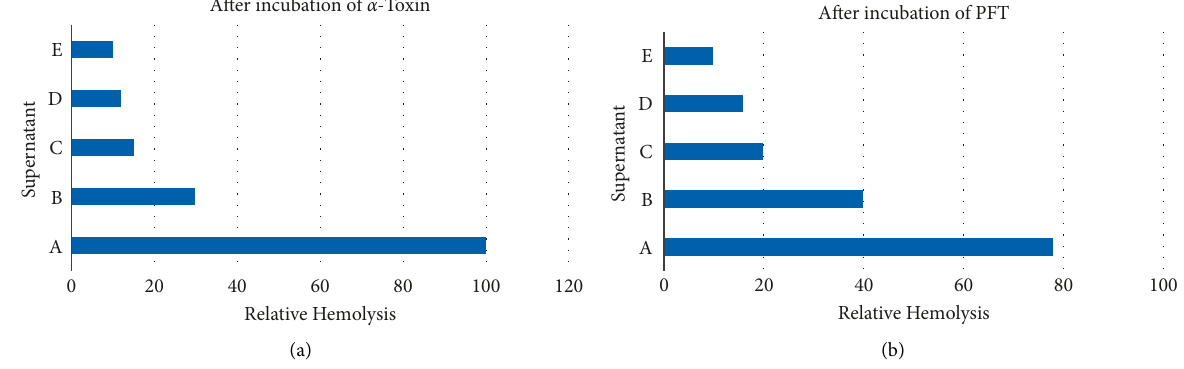
Figure 8: (a) After incubation of α -toxin. (b) After incubation of PFT.